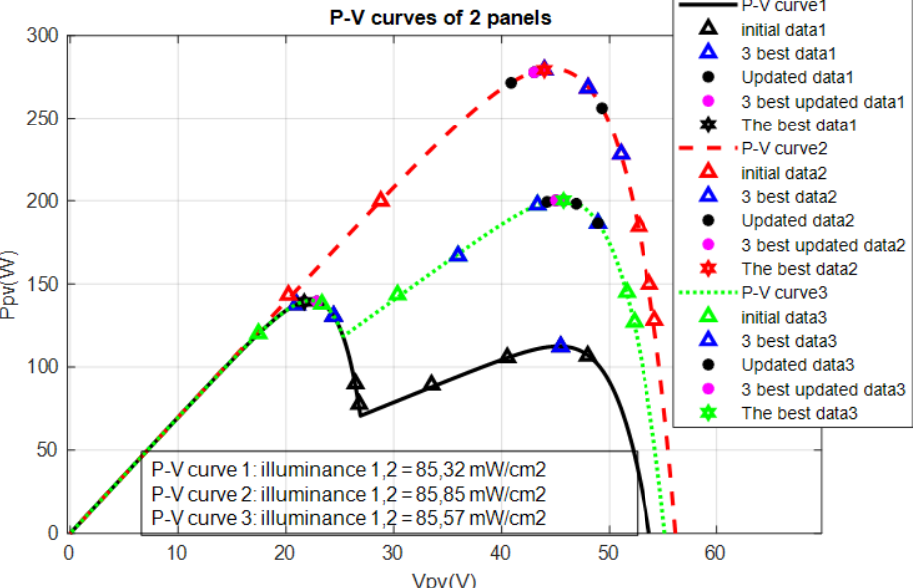
Figure 10. P -V curve characteristics of two serial PV panels. Figure 10. P-V curve characteristics of two serial PV panels.